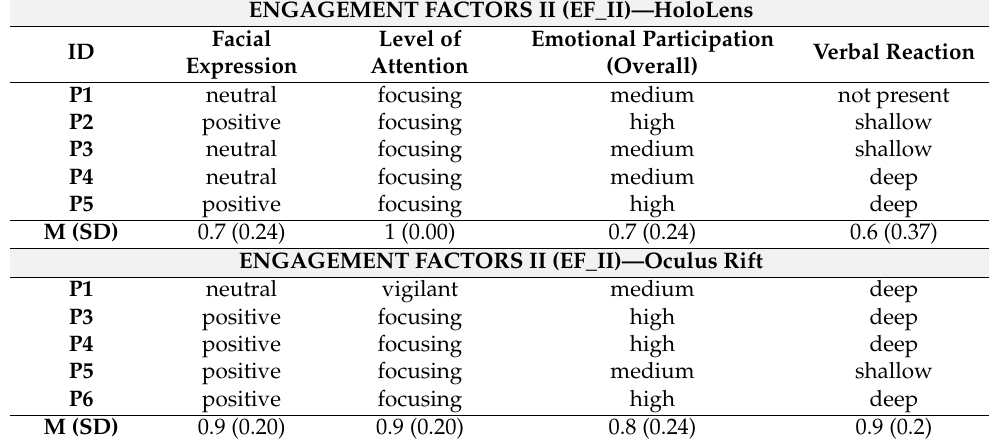
Table 8. Results for engagement factors II: mean (M) scores with standard deviation (SD).